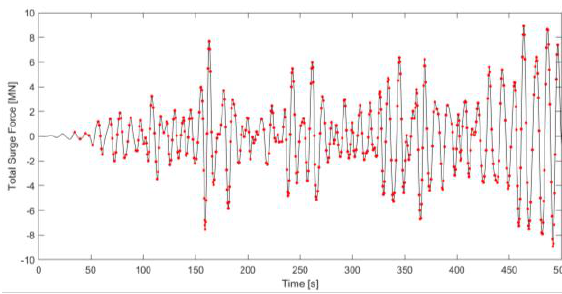
Fig. 7. Down-selection of 458 samples (in red) from a WEC- Sim transient comprising of 50,000 steps (shown in black)